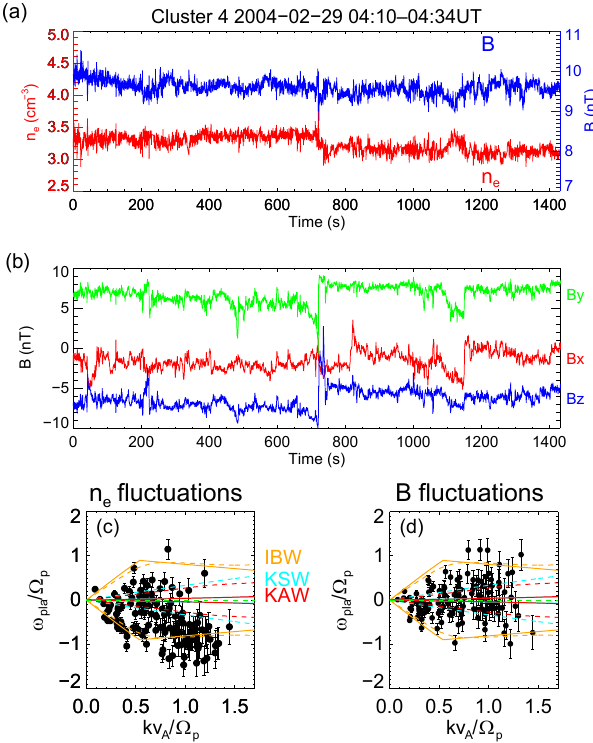
Figure 1. (a) Time series of the density (red) and the magnetic field strength (blue) fluctuations from the Cluster 4 spacecraft. (b) Time series of the magnetic field components in the GSE co-ordinate sys- tem. (c) Dispersion relation diagram of the electron density fluctu- ations (d) compressible magnetic fluctuations. Theoretical disper- sion relations for advected structures (green), KAWs (red), KSWs (cyan) and IBWs (orange) for propagation angles θ kB 75 ◦ (solid